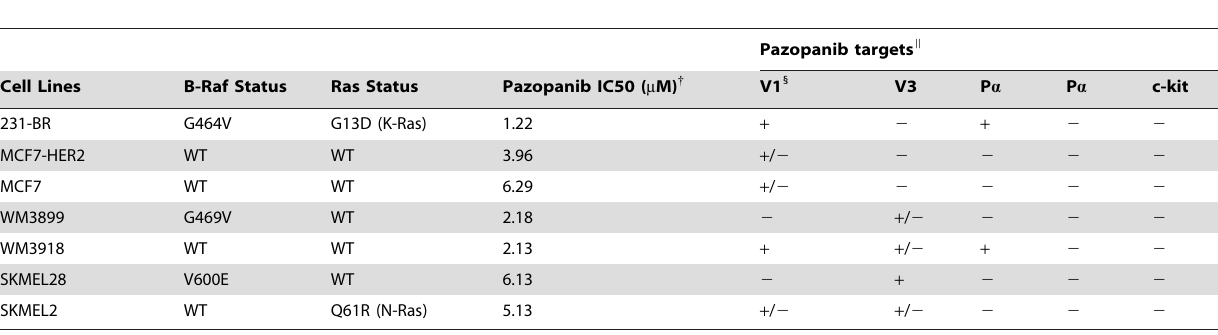
Table 1. In vitro growth inhibition by pazopanib on breast carcinoma and melanoma cell lines expressing different genotypes in the Ras-Raf-ERK1/2 pathway * .